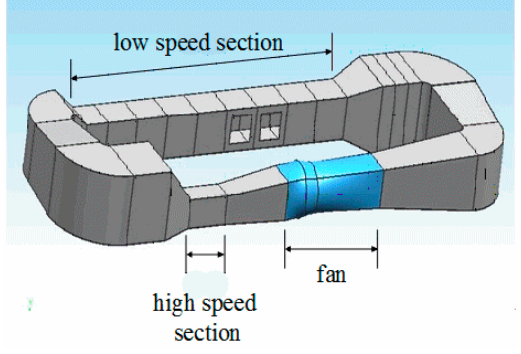
Figure 2. Insulator models in the wind tunnel, ( a ) XSP-160; and ( b ) XP13-160. Figure 1. Insulator models in the wind tunnel, ( a ) XSP-160; and ( b ) XP13-160. Energies 2017 , 10 , 1045 Table 1. The main parameters of the tested insulators.